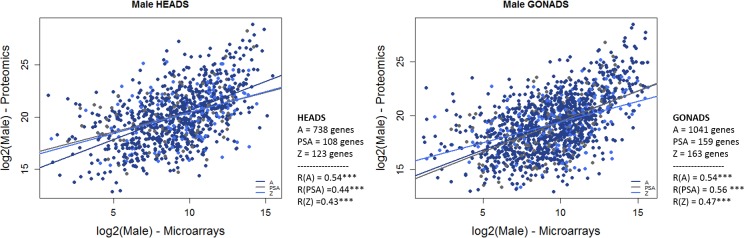
Pearson correlations between gene dosage at the transcript and protein levels in male heads and gonads.A positive correlation (coefficients R) is observed for Z-linked (Z, in light blue), pseudo-autosomal (PSA, in grey) and autosomal genes (A, in dark blue). The level of significance of each correlation is denoted by asterisks: *p-value<0.05, **p-value<0.001, ***p-value<0.0001. No significant difference was found between the correlations obtained for Z-linked and autosomal genes in either tissue (using a Fisher r-to-z transformation).